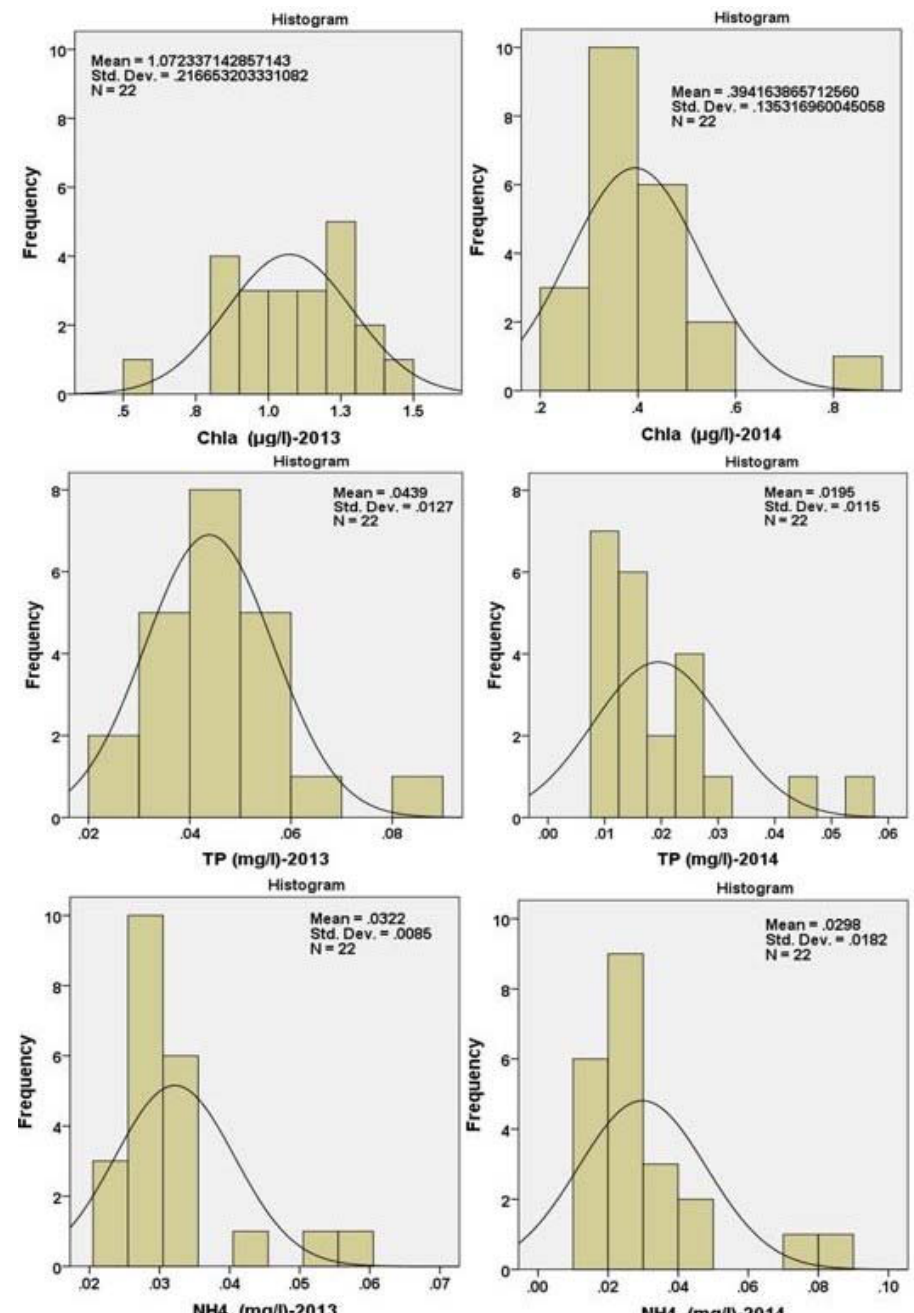
Figure 3. Frequency graphs presenting the distribution of the in-water constituents (Chl- a , TP and NH 4+ ) for both years.